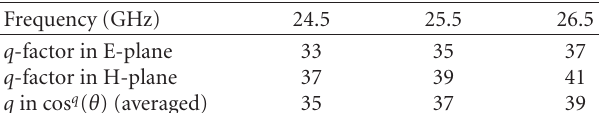
Figure 1: Scheme of the flat reflectarray. Table 1: Font sizes for papers values of q factor used to model the feed